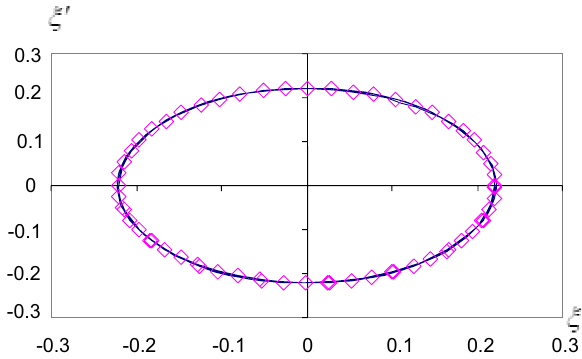
Figure 5. The stability diagram ( ξ ′ , ξ